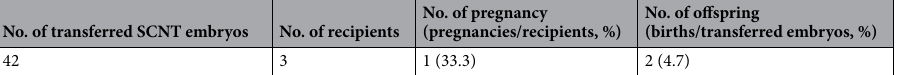
Table 1. Production of C > T dogs by somatic cell nuclear transfer (SCNT). The number of oocytes used for SCNT is shown. A total of 42 mature oocytes were used. Three dogs donated oocytes, and one dog was used as a surrogate mother. A total of two cloned dogs were achieved.